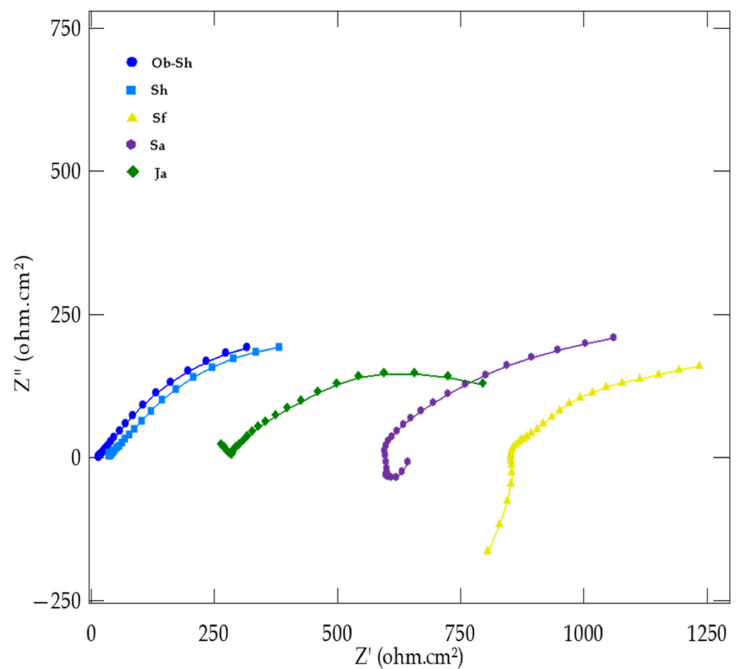
Figure 9. Nyquist plots for the corrosion of CSX36 specimen in the studied Jeddah soil solutions at 30 ± 1 ◦ C.